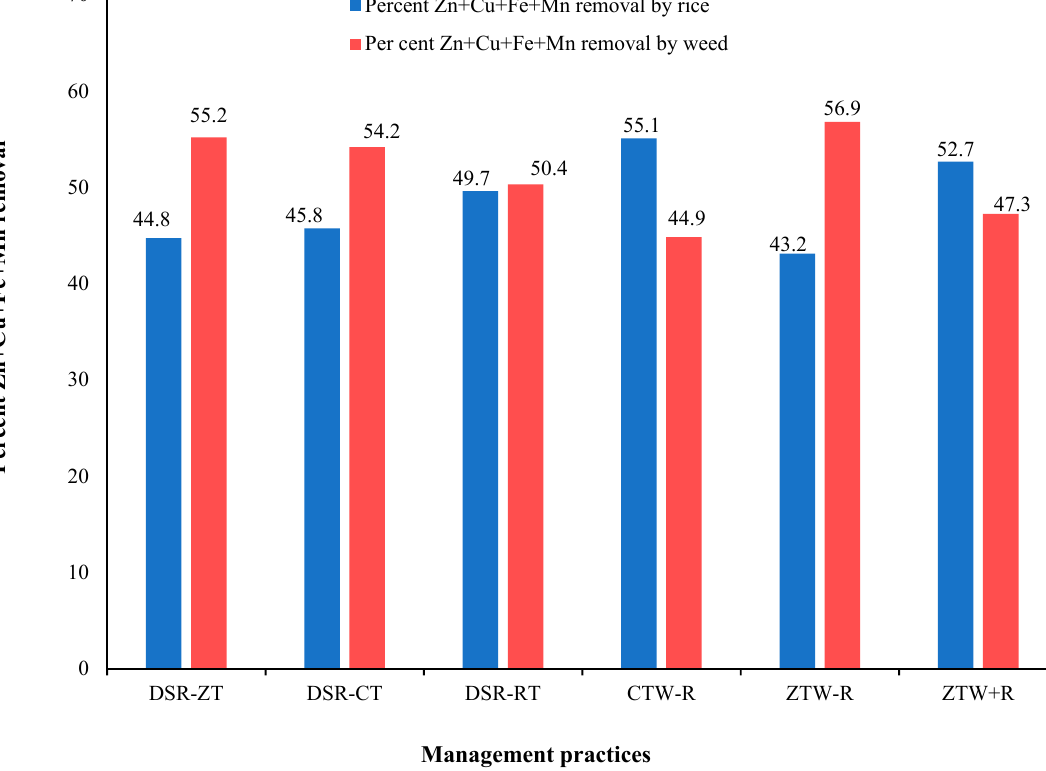
Figure 2. Percentage of micronutrients (Zn + Cu + Fe + Mn) removed by rice and weed under different management practices. DSR (Direct-seeded rice), CT (Conventional tillage), RT (Reduced tillage), ZT (Zero tillage), CTW (Conventional till wheat), ZTW (Zero till wheat), R (Rice residue).